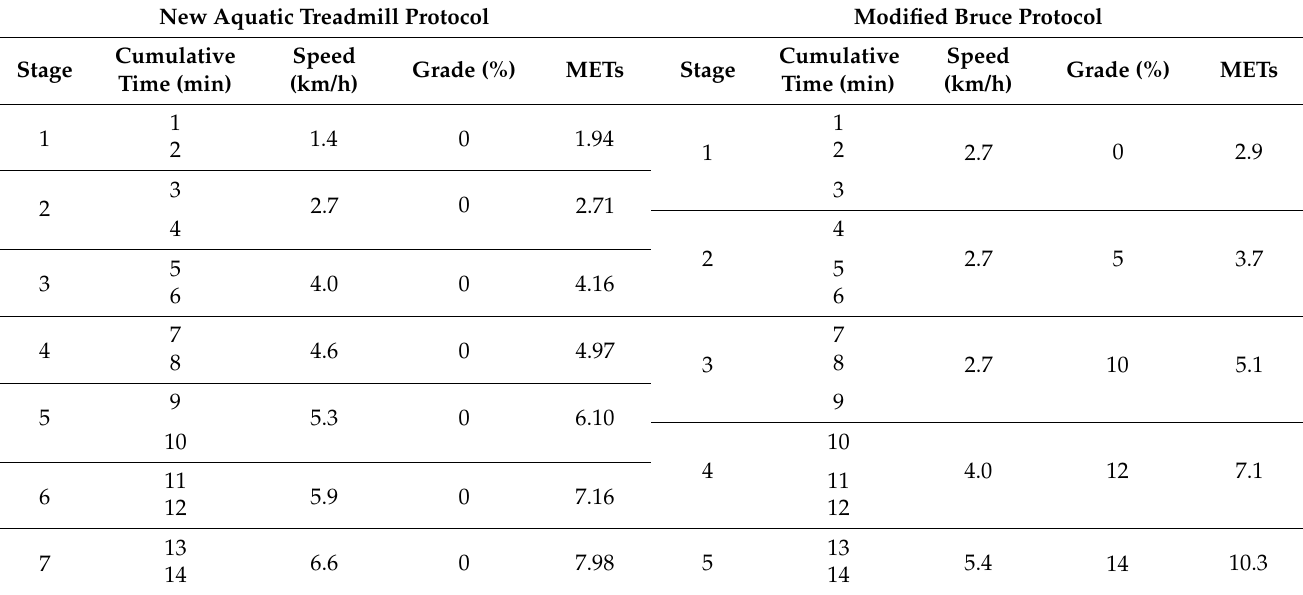
Table 3. Comparison of our new aquatic treadmill protocol data and modified Bruce protocol data.